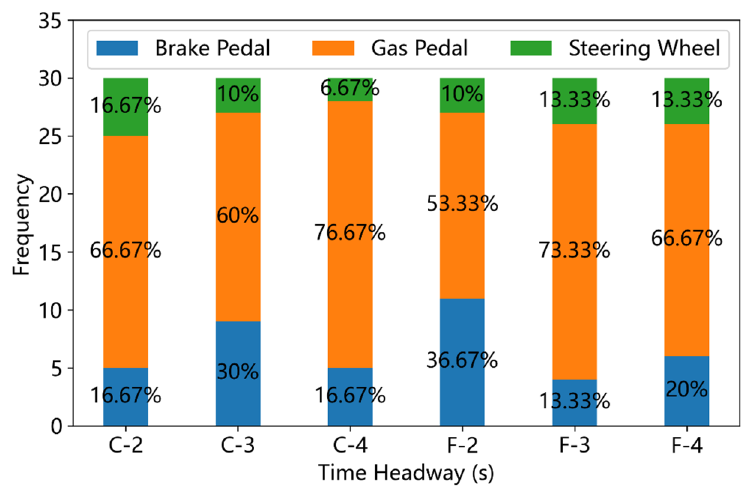
Figure 7. Frequency of different takeover responses under non-critical driving scenarios (C means ‘clear weather’ and F denotes ‘fog condition’). choice of takeover responses.